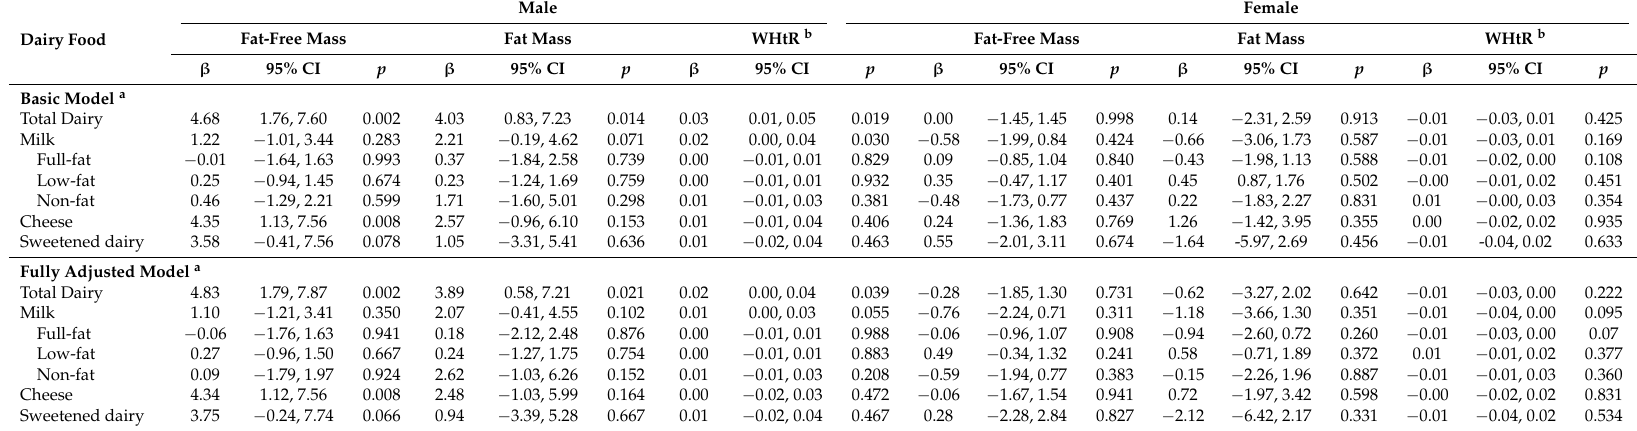
Table 4. Association * between types of dairy foods intake (servings/day) and body composition and indicator of central adiposity, by gender.